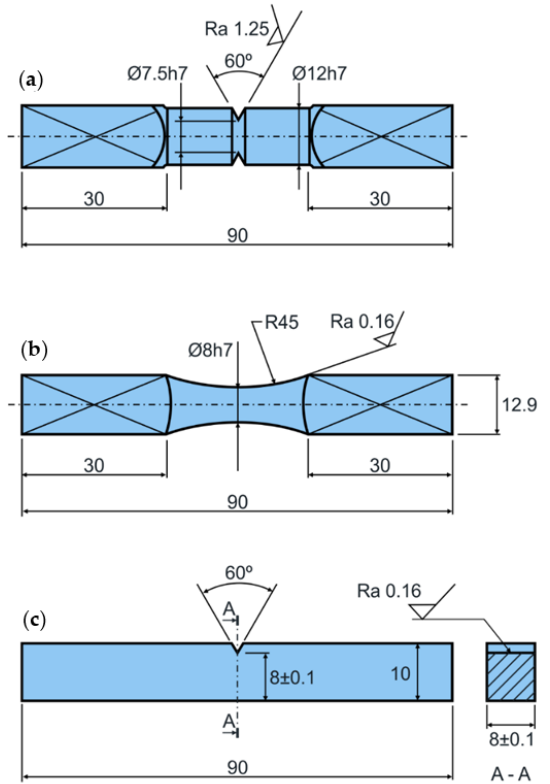
Figure 1. Specimen geometries utilised in fatigue campaign: ( a ) 10HNAP steel, ( b ) S355J2 steel, and ( c ) 2017-T4 aluminium alloy (dimensions in millimetres). Adapted from [37]. Table 1. Fatigue tests parameters.